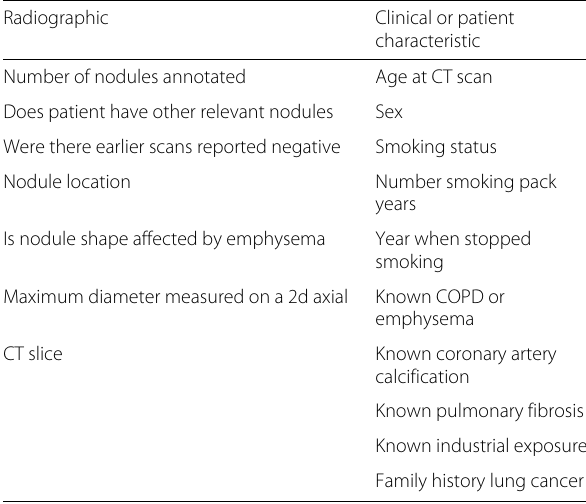
Table 2 Candidate